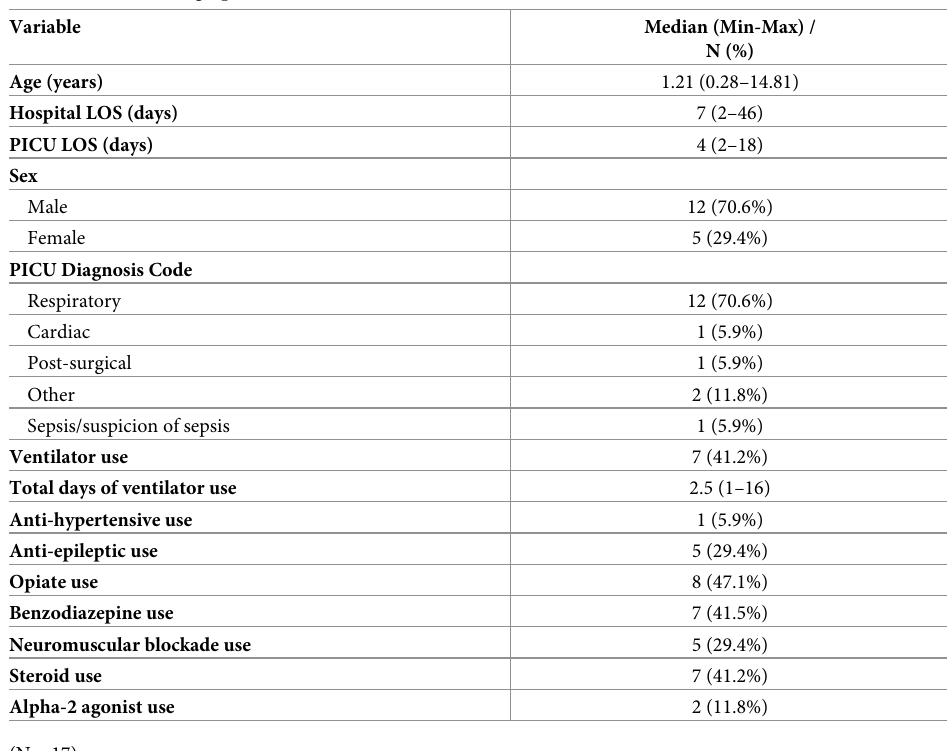
Table 1. Patient demographic and clinical characteristics.